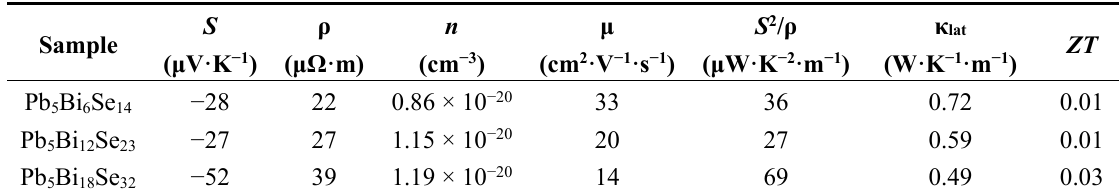
Table 3. Seebeck coefficient ( S ), electrical resistivity ( ρ ), carrier concentration ( n ), carrier mobility ( μ ), power factor ( S 2 / ρ ), lattice thermal conductivity ( κ lat ), and thermoelectric figure of merit ( ZT ) at room temperature in three members of the cannizzarite homologous